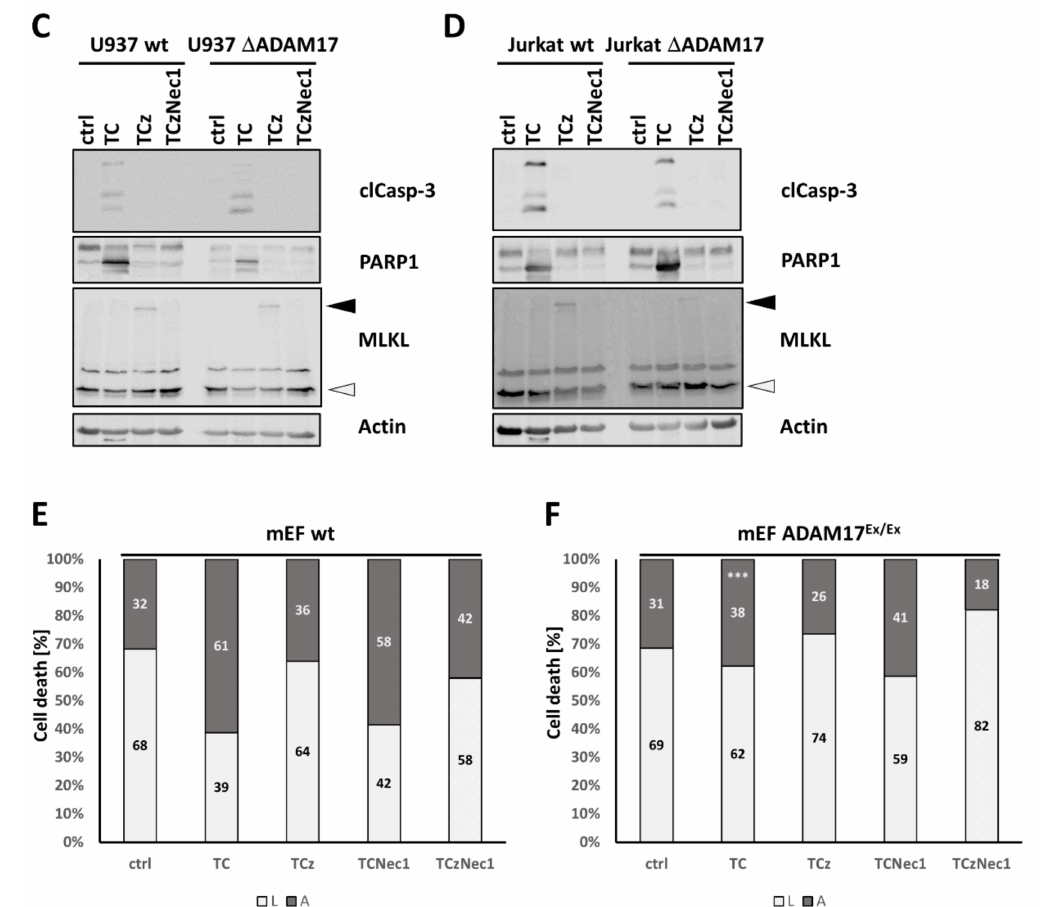
Figure 4. Analysis of TNF mediated cell death in wt versus ∆ ADAM17 cells. Cell death analysis in ( A ) U937 and ( B ) Jurkat cells, upon quantification by flow cytometry. The percentage of living (L, white), apoptotic (A, grey) and necroptotic (N, black) cells are shown. ( C , D ) depict Western blots probed for cleaved Caspase-3, PARP1 and MLKL, with actin as loading control. Where indicated, cells were incubated for 20 h in the presence of T, TC or TCz. ( E , F ) depict cell death induction in murine embryonic fibroblast cells derived from wt and animals with reduced ADAM17 levels (ADAM17 Ex/Ex ). We observed no necroptosis induction in either of the cell lines (see also Figure S1C); thus, only the percentages of living (L, white) and apoptotic (A, grey) cells are shown. Where applicable, statistical significance based on Student’s t -test is indicated (* p < 0.05; *** p < 0.001). Representative results of at least n = 3 experiments are